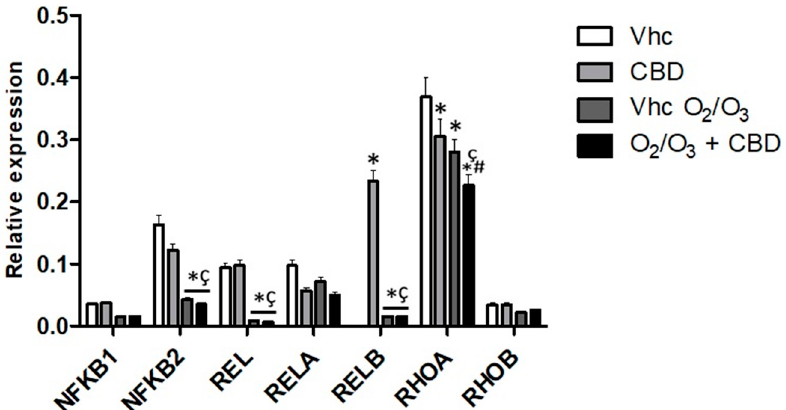
Figure 13. Modulation of NF-kB pathways in PANC-1 cell line. NFKB1 , NFKB2 , REL , RELA , RELB , RHOA , and RHOB mRNA expression was evaluated by qRT-PCR in the PANC-1 cell line, treated with CBD in the presence and absence of O 2 /O 3 . Target mRNA levels were normalized for GAPDH expression. Data are expressed as fold mean ± SE. * p < 0.05 vs. Vhc, #, * p < 0.05 vs. Vhc O 2 /O 3 , ç p < 0.05 vs. CBD.